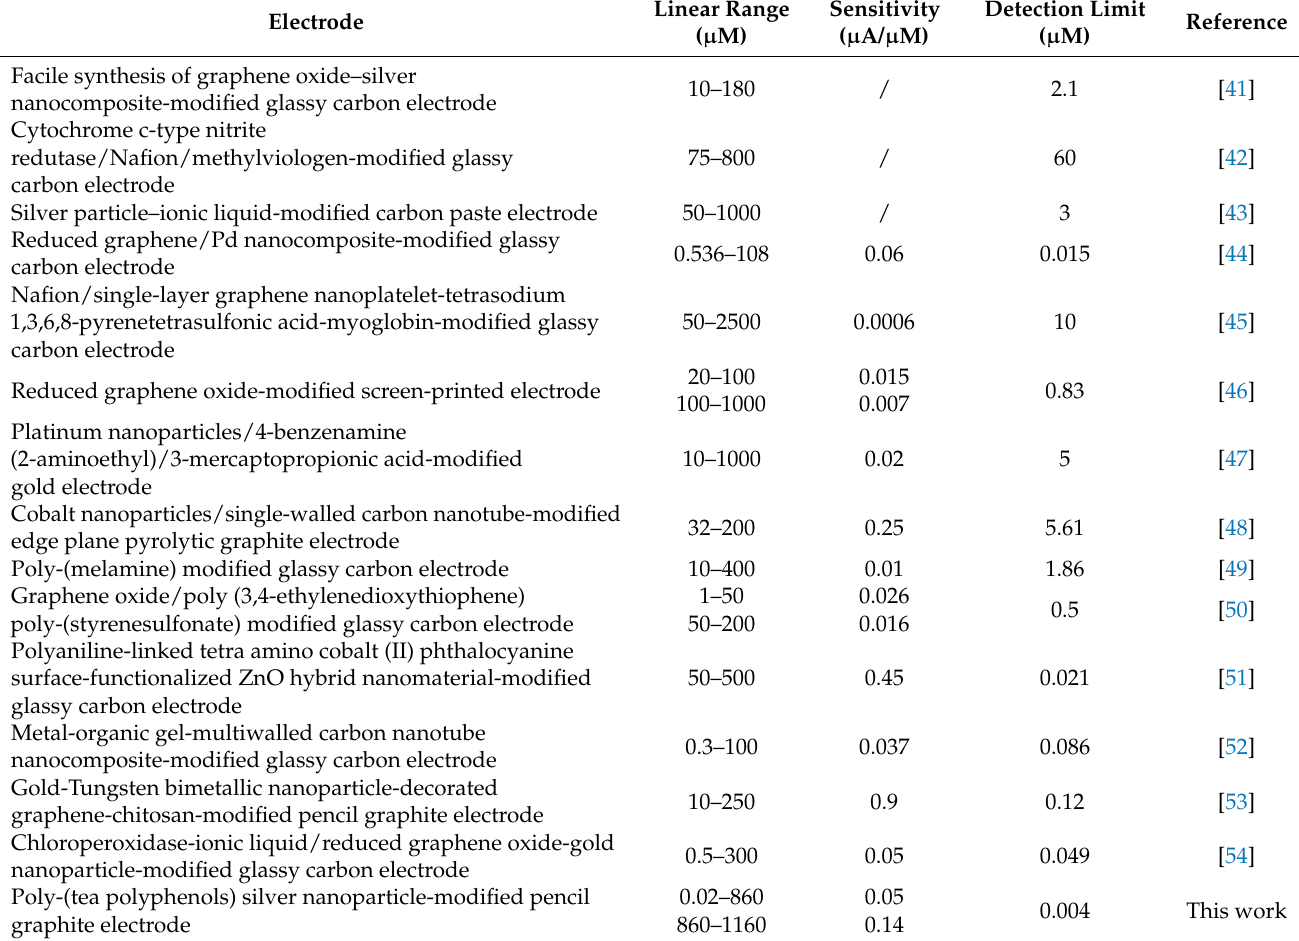
Table 1. Comparison of the performances of different electrochemical sensors for nitrite.